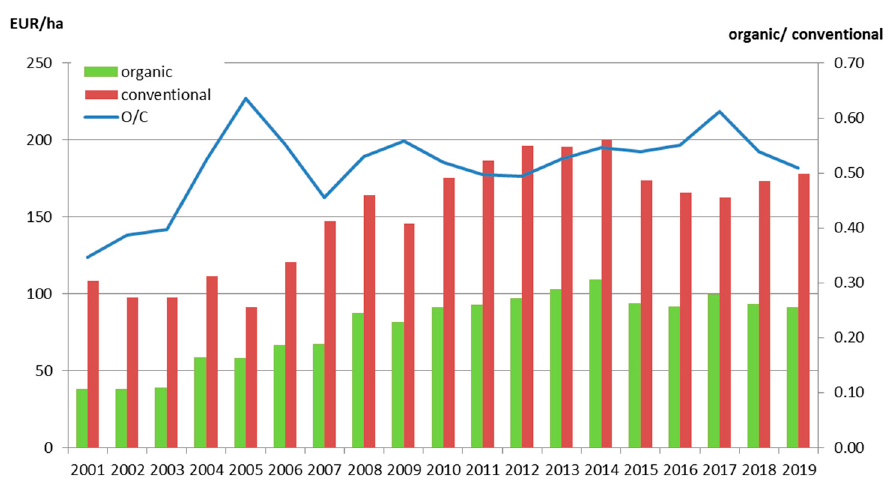
Figure 4. Energy consumption one hectare. (Source: [38], authors’ elaboration).